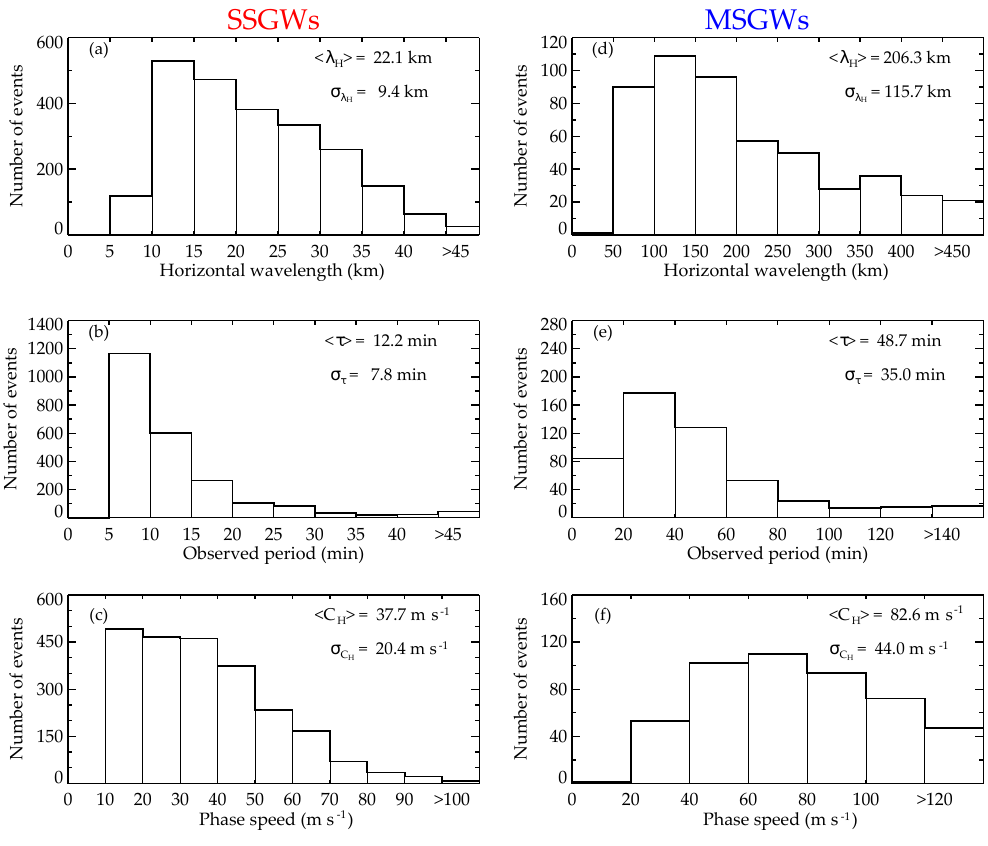
Figure 4. Histogram plots summarizing the characteristics of SSGWs and